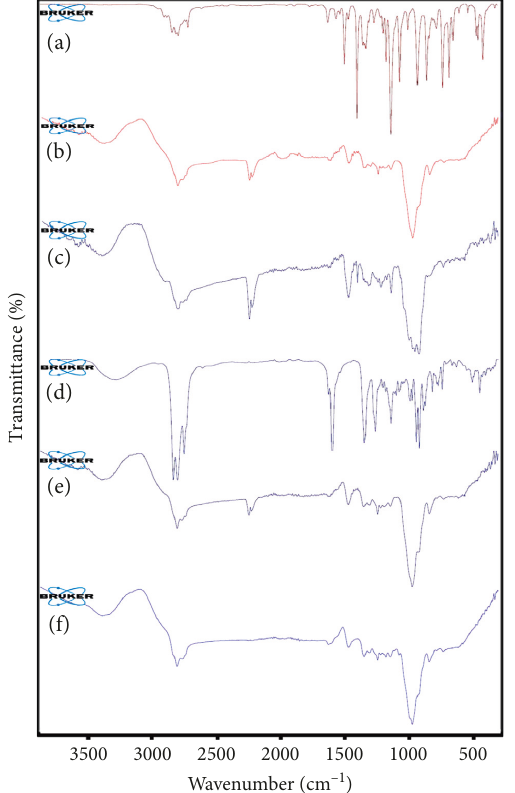
Figure 4: ATR-FTIR spectra of (a) F. vulgare EO, (b) blank gel, (c) nanogel containing F. vulgare EO (FVNG), (d) M. piperita EO, (e) blank gel, and (f) nanogel containing M. piperita EO (MPNG).